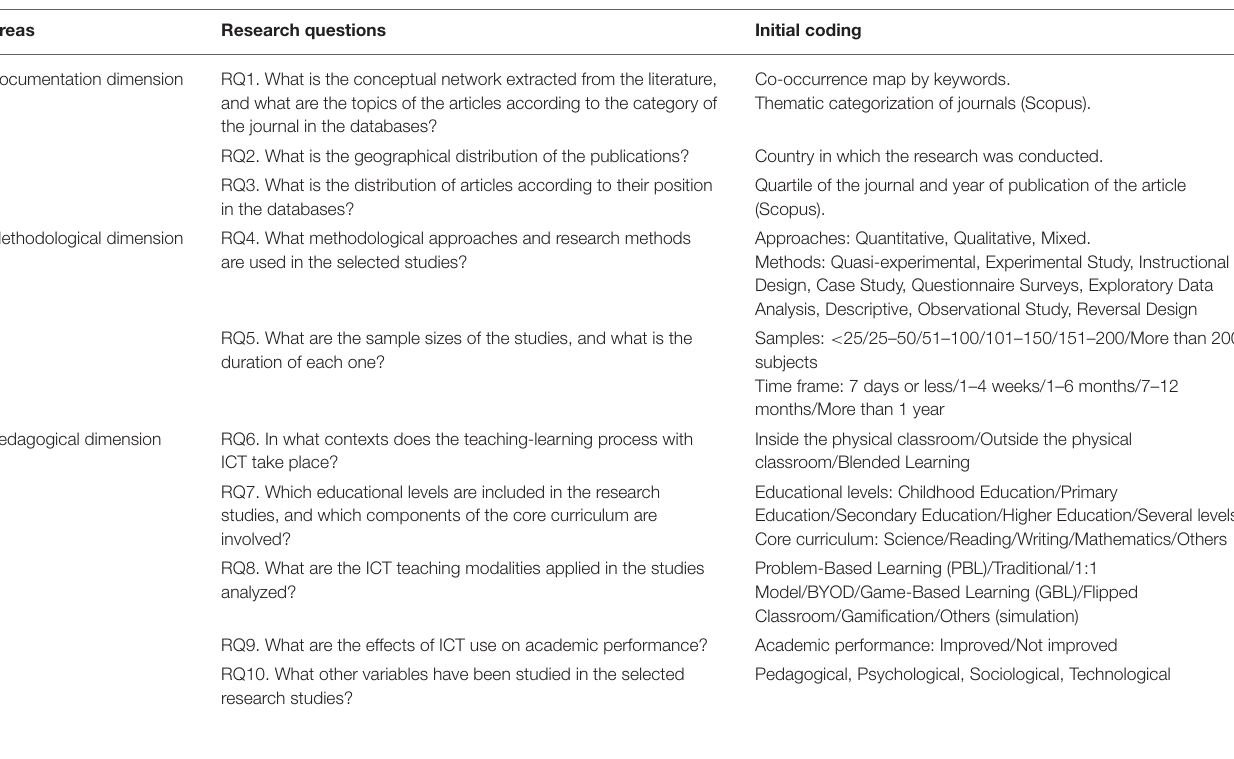
TABLE 1 | Areas, research questions, and initial coding